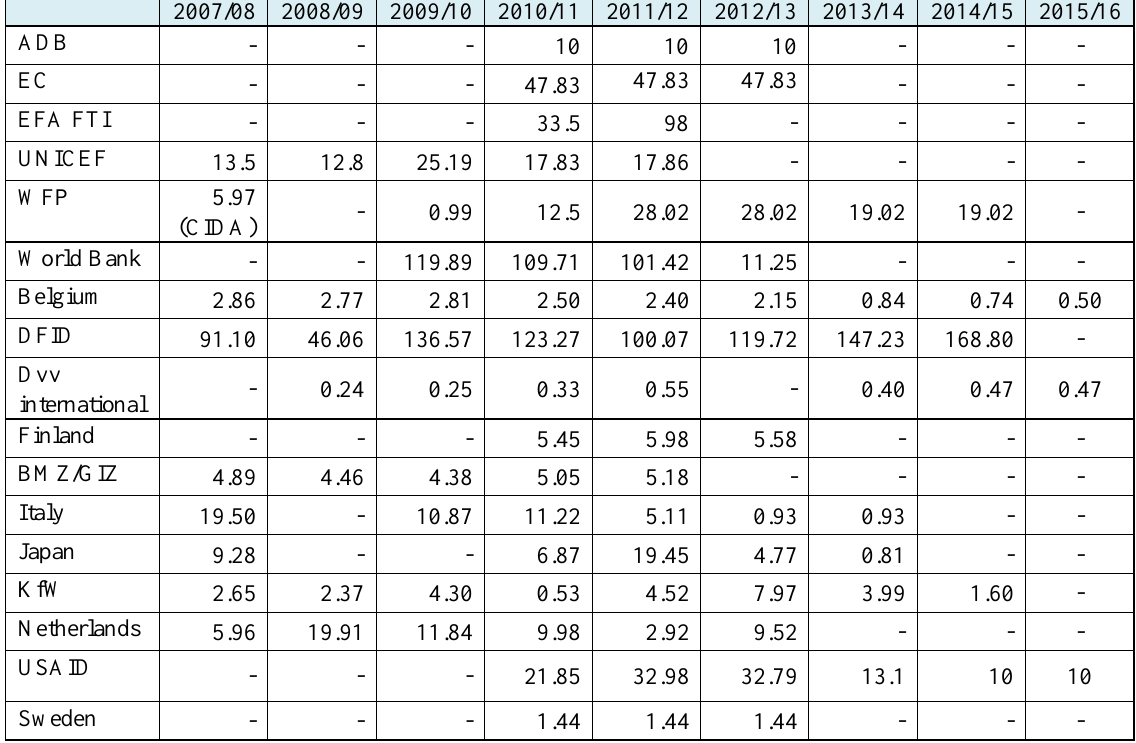
Table 6-3: Amount of Donor Support (2007/08 - 2015/16) (million